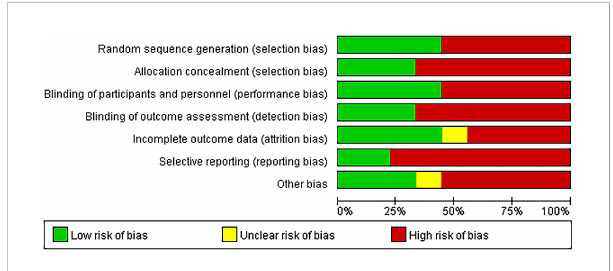
FIGURE 2 Proportion chart of methodological quality